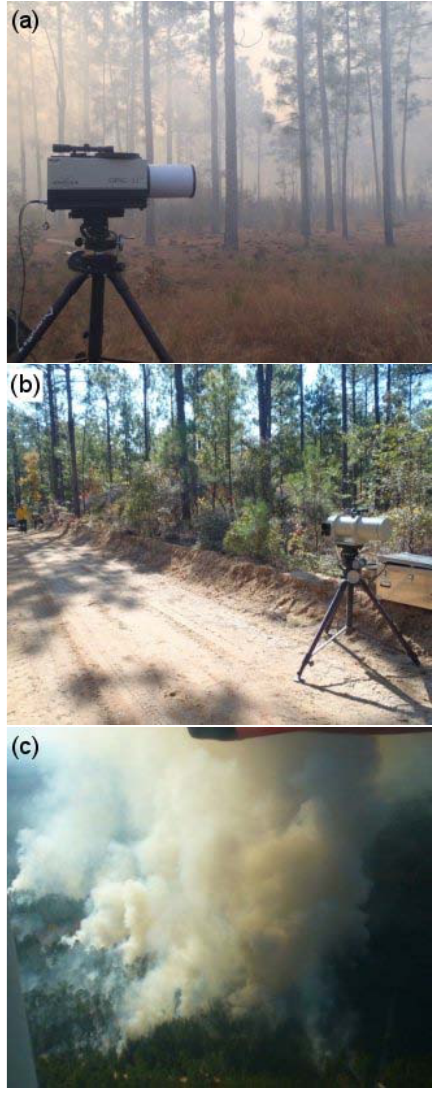
Fig. 1. (a) Photograph of the OPAG-22 spectrometer system with receiver telescope in the field during the 2 November fire. (b) Pho- tograph of the sender and receiver telescopes separated by an opti- cal path of ∼ 30m taken in clean air before ignition on 30 October. (c) Photograph of the 2 November fire from the airborne platform used by the airborne FTIR system. Pictures of fuels sampled by the LAFTIR can be found in Akagi et al.